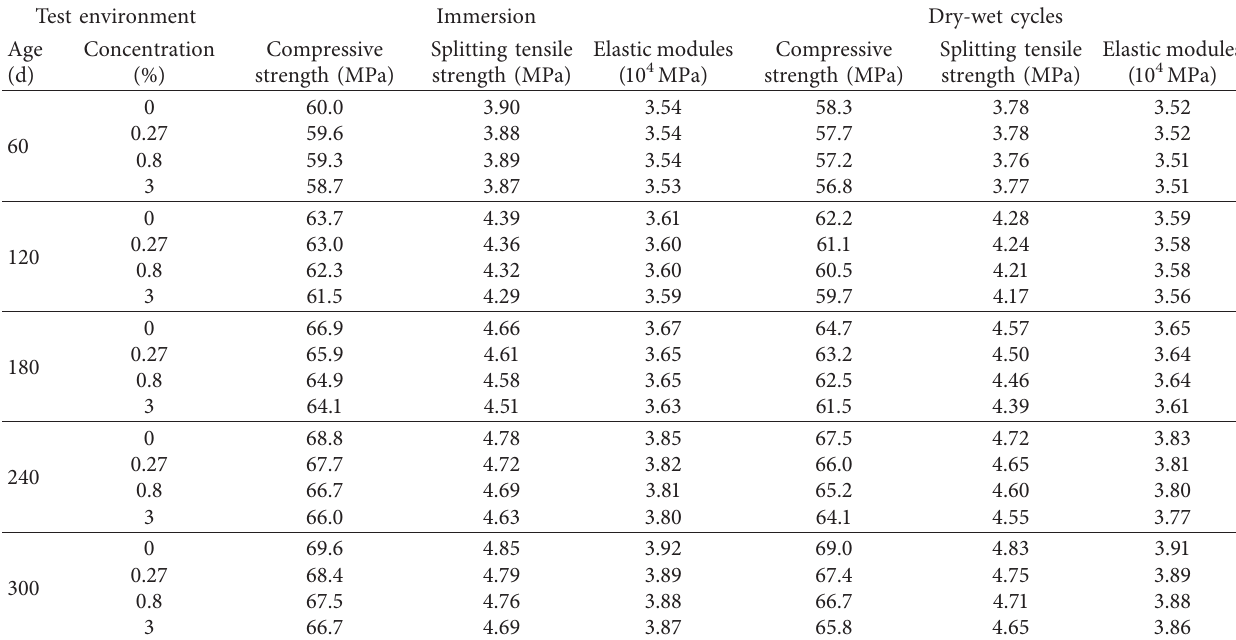
Table 2: Mechanical properties of